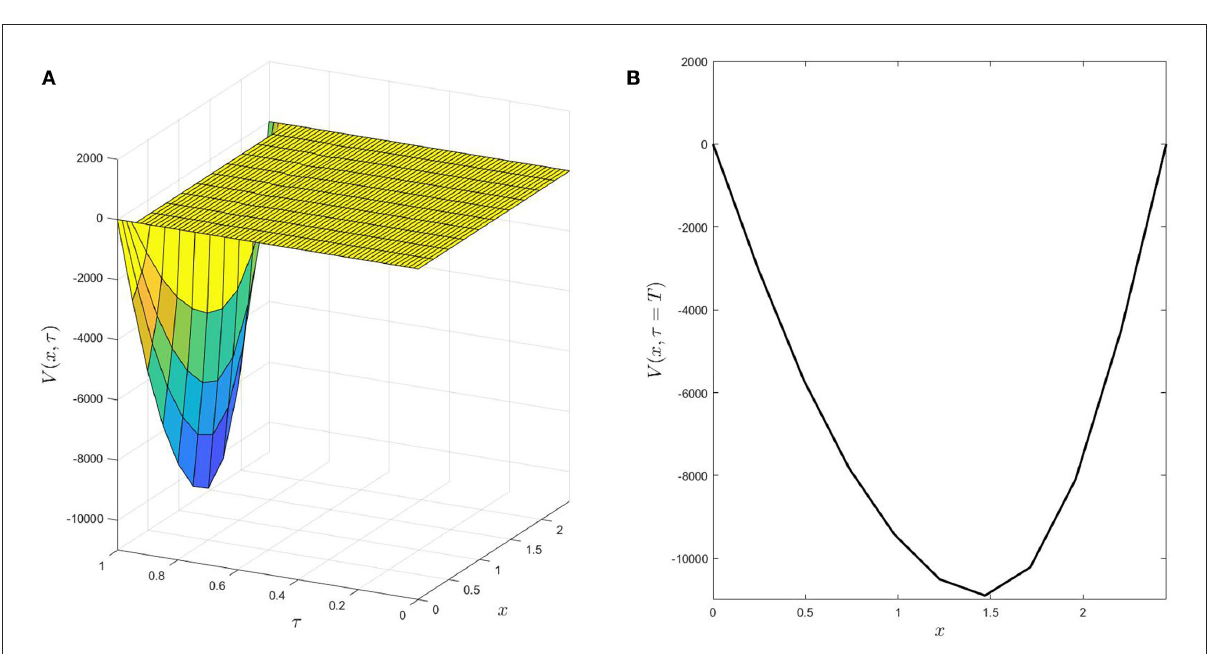
FIGURE8 (A,B) The behavior of numerical solutions of Example 3 when the stability condition (Equation 28) is broken with respect to 1 x for θ